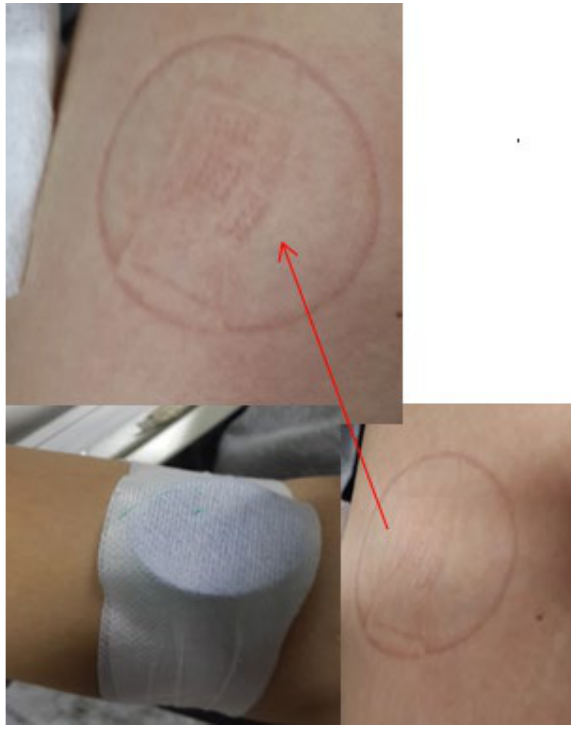
Figure 1. Minimally invasive wound after CGMS use, this small wound will cause almost no pain and no bleeding. Table 1. Characteristics of the commercial continuous glucose monitoring